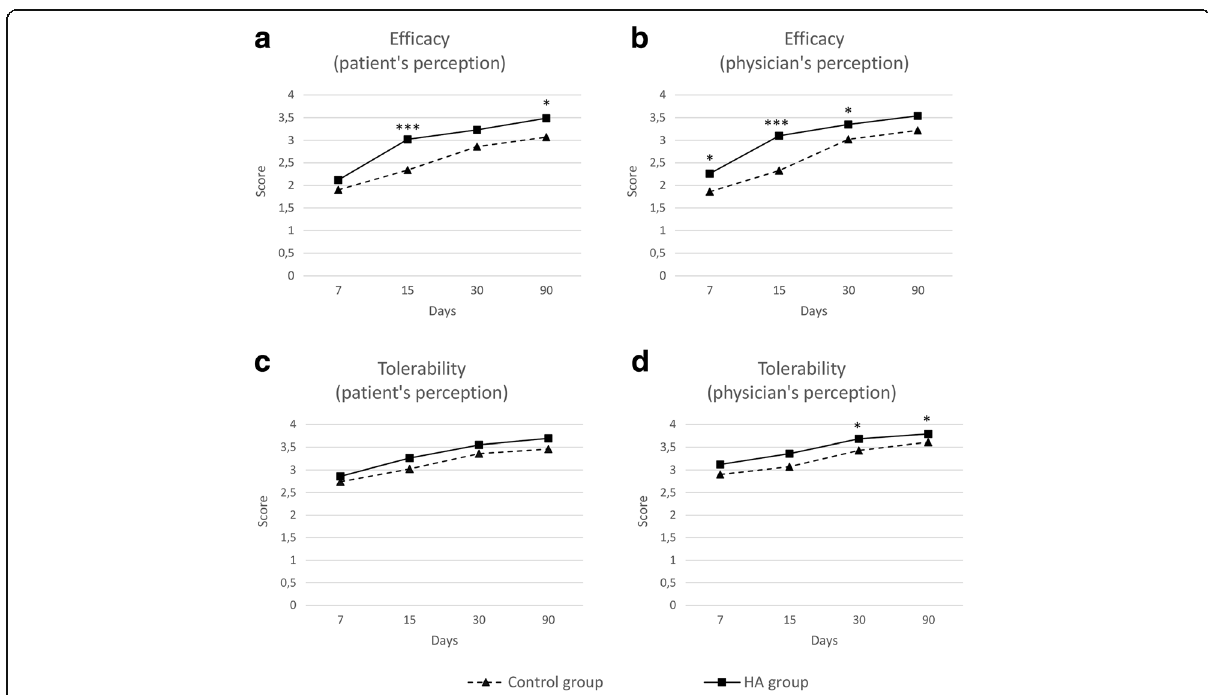
Fig. 3 Perceived efficacy ( a , b ) and tolerability ( c , d ) outcomes, assessed on a 4-point Likert scale. * p < 0.05 for control vs. HA groups comparison. ** p < 0.01 for control vs. HA groups comparison. *** p < 0.001 for control vs. HA groups